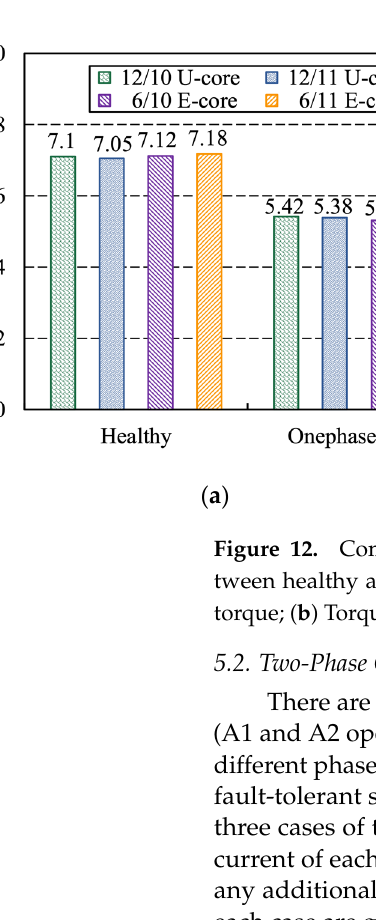
Figure 11. Electromagnetic torque under one-phase open-circuit and fault-tolerant control opera- tion condition of four candidates. ( a ) One-phase open-circuit; ( b ) fault-tolerant control operation.